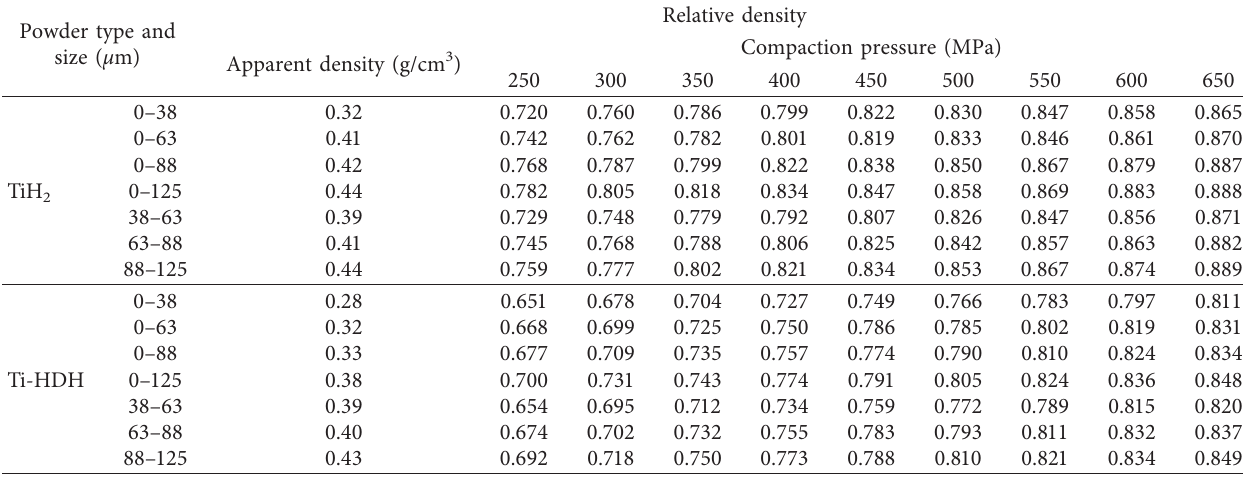
Table 2: Apparent relative densities of TiH 2 and HDH titanium powders of various particle sizes, as well as relative densities of cor- responding green compacts pressed at 250–650MPa. Theoretical density of bulk materials was taken as 3.75g/cm 3 for TiH 2 and 4.51 g/cm 3 for HDH-Ti.